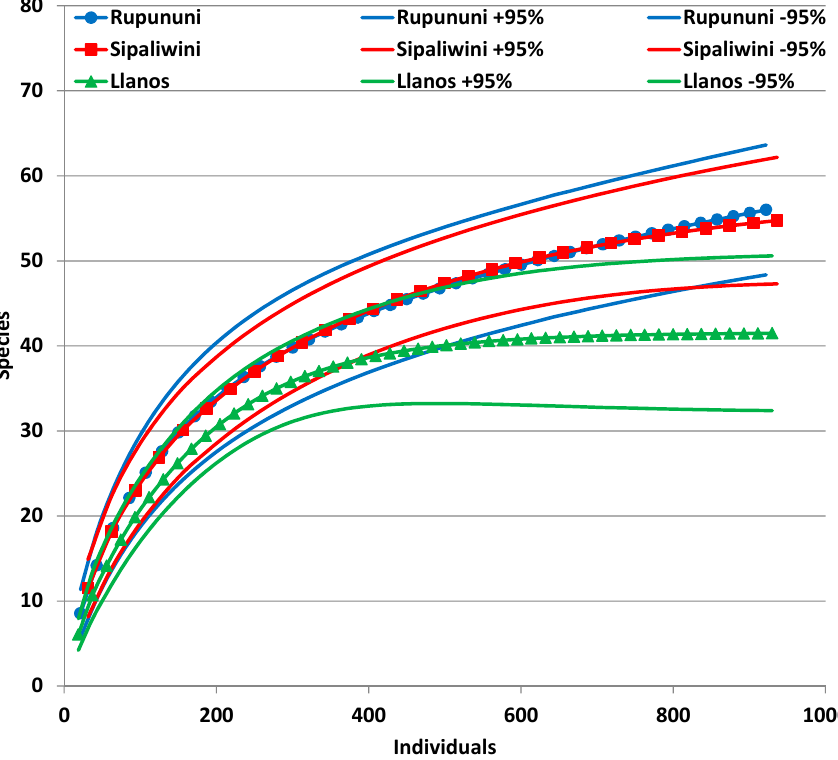
Figure 3. Species accumulation curves with 95% confidence intervals of bats surveyed in three savanna habitats in the Guianas with the Llanos extrapolated from 279 individuals and Sipaliwini extrapolated from 562 individuals to match more closely the 922 individuals of the Rupununi.